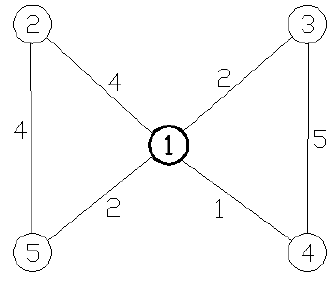
Figure 1. Topological model of emergency logistics network.